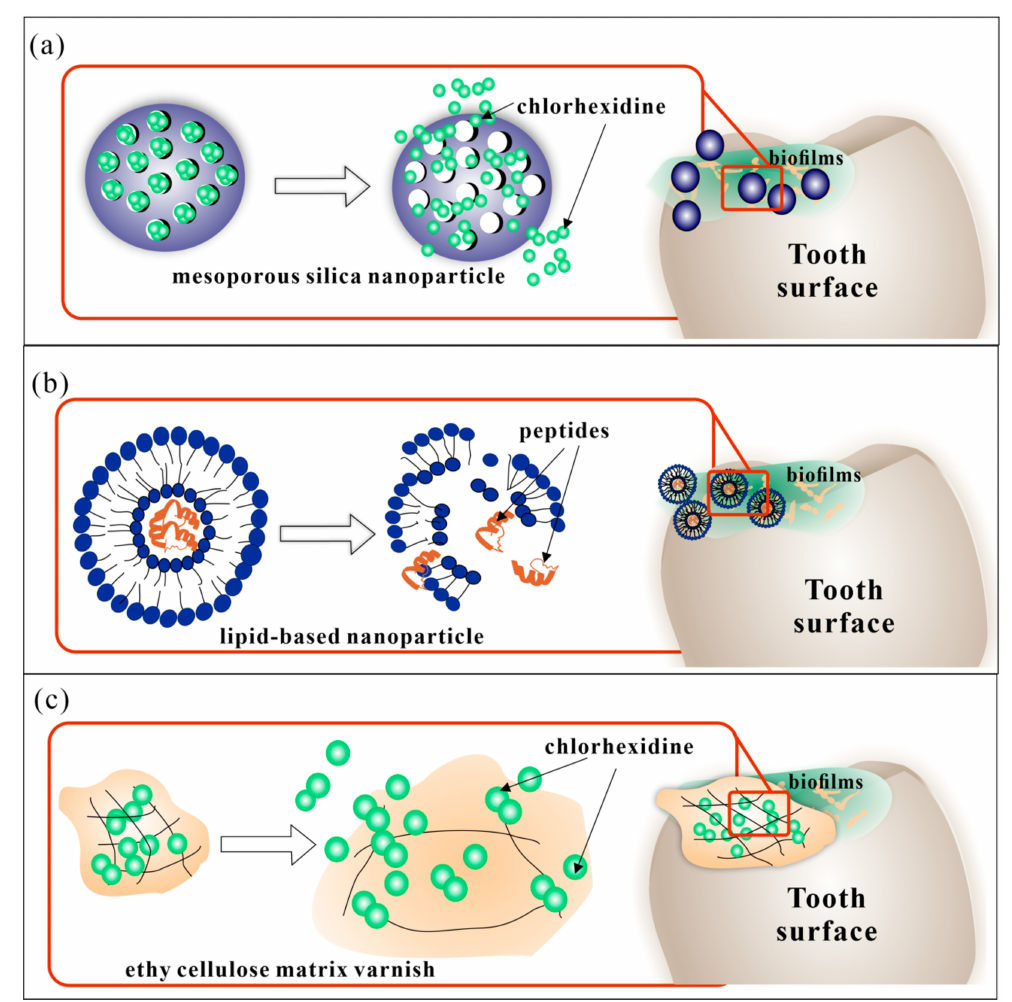
Figure2. Recentanti-bacterialDDSfordentalcaries. ( a )chlorhexidineloadedmesoporousnanoparticles; ( b ) peptides loaded lipid-based nanoparticle; ( c ) chlorhexidine loaded ethy cellulose matrix